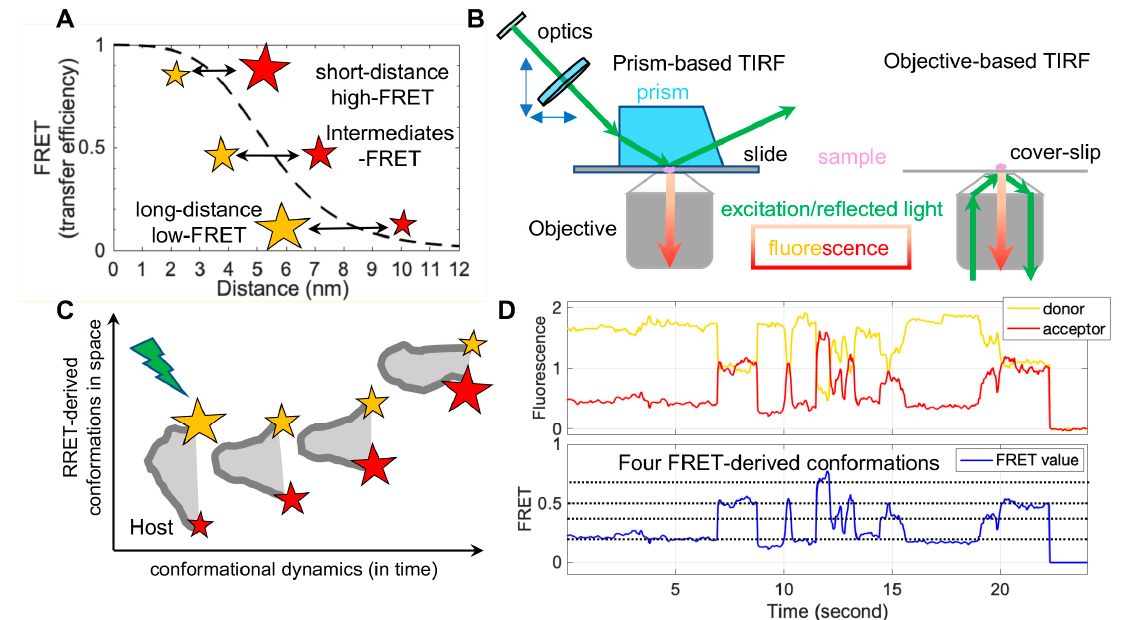
Figure 2. Single-molecule Förster resonance energy transfer (smFRET) principle, instrumentation, and imaging of dynamic biomolecules. ( A ) An example curve depicting energy transfer efficiency (Förster resonance energy transfer (FRET), dashed black line) from an excited donor fluorophore to a neighboring acceptor fluorophore as a function of donor–acceptor distances. FRET values or FRET negatively correlate with the distance within a couple of nanometers between a donor (yellow star) and an acceptor (red star). ( B ) Widely used smFRET imaging instrumentations: prism- and objective-based total internal reflection fluorescence (TIRF). ( C , D ) Real-time observations of conformational motions in biomolecules by smFRET. ( C ) Diagram depicting ideal FRET-derived space-time coordinates of biomolecule conformations. Donor, yellow star; acceptor, red star; relative fluorescence intensity, the star’s size; biomolecule of interest, gray. ( D ) Example FRET-related traces showing four interconvertible conformations in real time. The host molecule dynamically samples four conformations, reflected by different donor–acceptor energy transfer efficiencies. Donor fluorescence trace, solid yellow line; acceptor fluorescence trace, solid red line; calculated FRET trace, solid blue line; FRET-indicated conformations, dashed black lines.